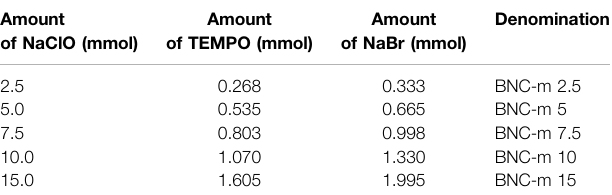
TABLE 1 | Modi fi cations were carried out with their respective variables and denominations. Amount of NaClO